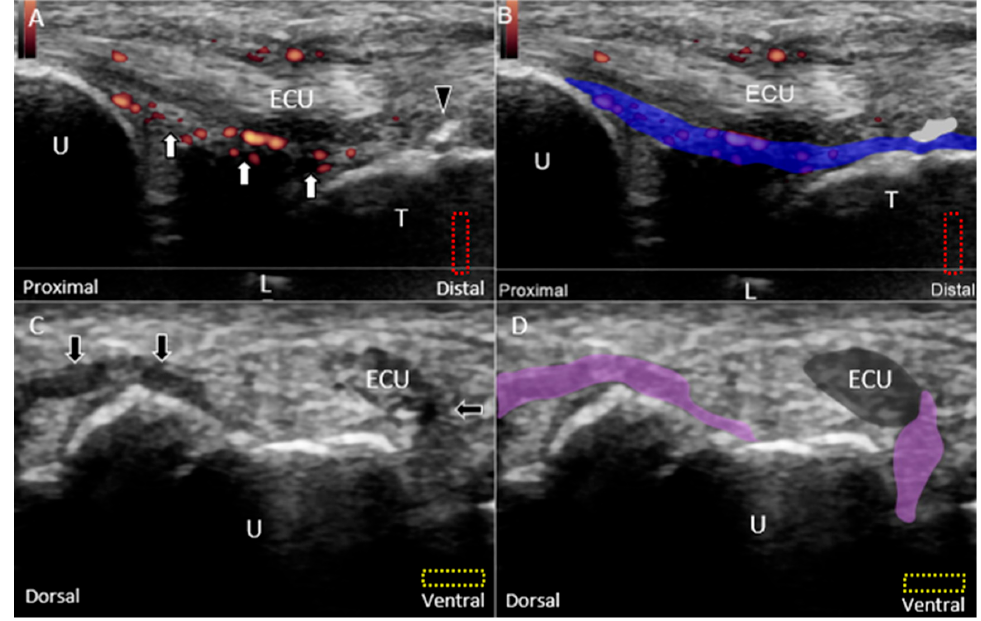
Figure 15. ( A ) Doppler US and ( B ) superposed images show the hypervascular and swollen ulnar collateral ligament (white arrow and blue shade) and ECU tendon as well as an avulsed fragment of the triquetrum (black arrowhead and grey shade) under the long ‐ axis approach. ( C ) US and ( D ) superposed US images show rupture of the ECU tendon subsheath (black arrow and purple shade) with subluxation of the extensor carpi ulnaris (ECU) tendon (dark grey shade) using the short ‐ axis approach. The different color dashed rectangles are in accordance with the transducer positions in Figure 3 . US: ultrasound; U: ulna; L: lunate; T: triquetrum; ECU: extensor carpi ulnaris. Class 2 injuries indicate degeneration of the TFCC with or without precedent trauma [1]. The severity is incremental from Class 2A to 2E [36]. Class 2A injuries indicate wear of the articular disc. US imaging may reveal that the articular disc at the affected site becomes thinner and has a more irregular border than that at the contralateral site. Class 2B injuries indicate articular disc wear with adjacent chondromalacia demonstrated by thinning of the articular disc and juxta ‐ articular cartilage and irregular cortex of the adjacent carpal bones (Figure 16A,B). Class 2C injuries are similar to Class 2B injuries but may progress to disc rupture. Class 2D injuries refer to additional lunotriquetral ligament ruptures (Figure 16C,D). The most severe type is Class 2E injuries, suggesting arthritis and synovitis of the ulnocarpal and radioulnar joints with a large tear of the articular disc [29].